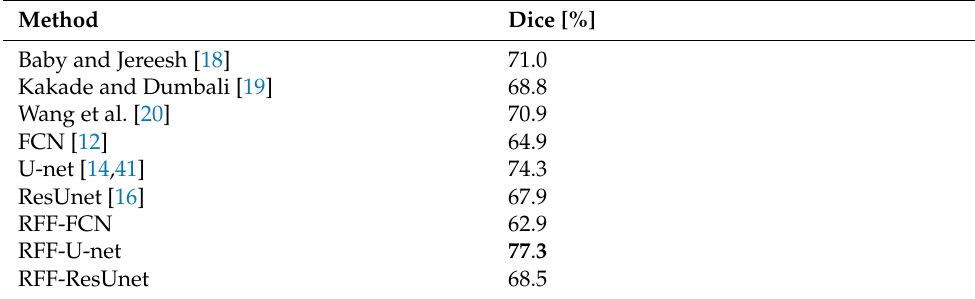
Table 3. Method comparison results for NSD dataset (brachial plexus nerve segmentation). The average Dice is presented regarding the testing set. Bold: highest Dice-based performance.